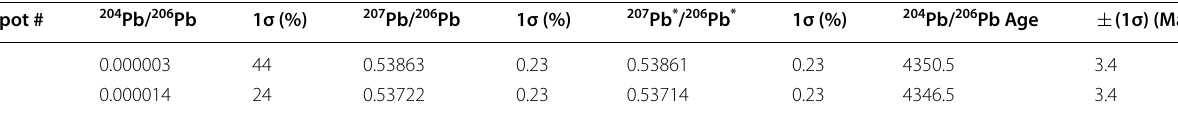
207 Pb * / 206 Pb * ratios are 204 Pb-corrected for terrestrial common